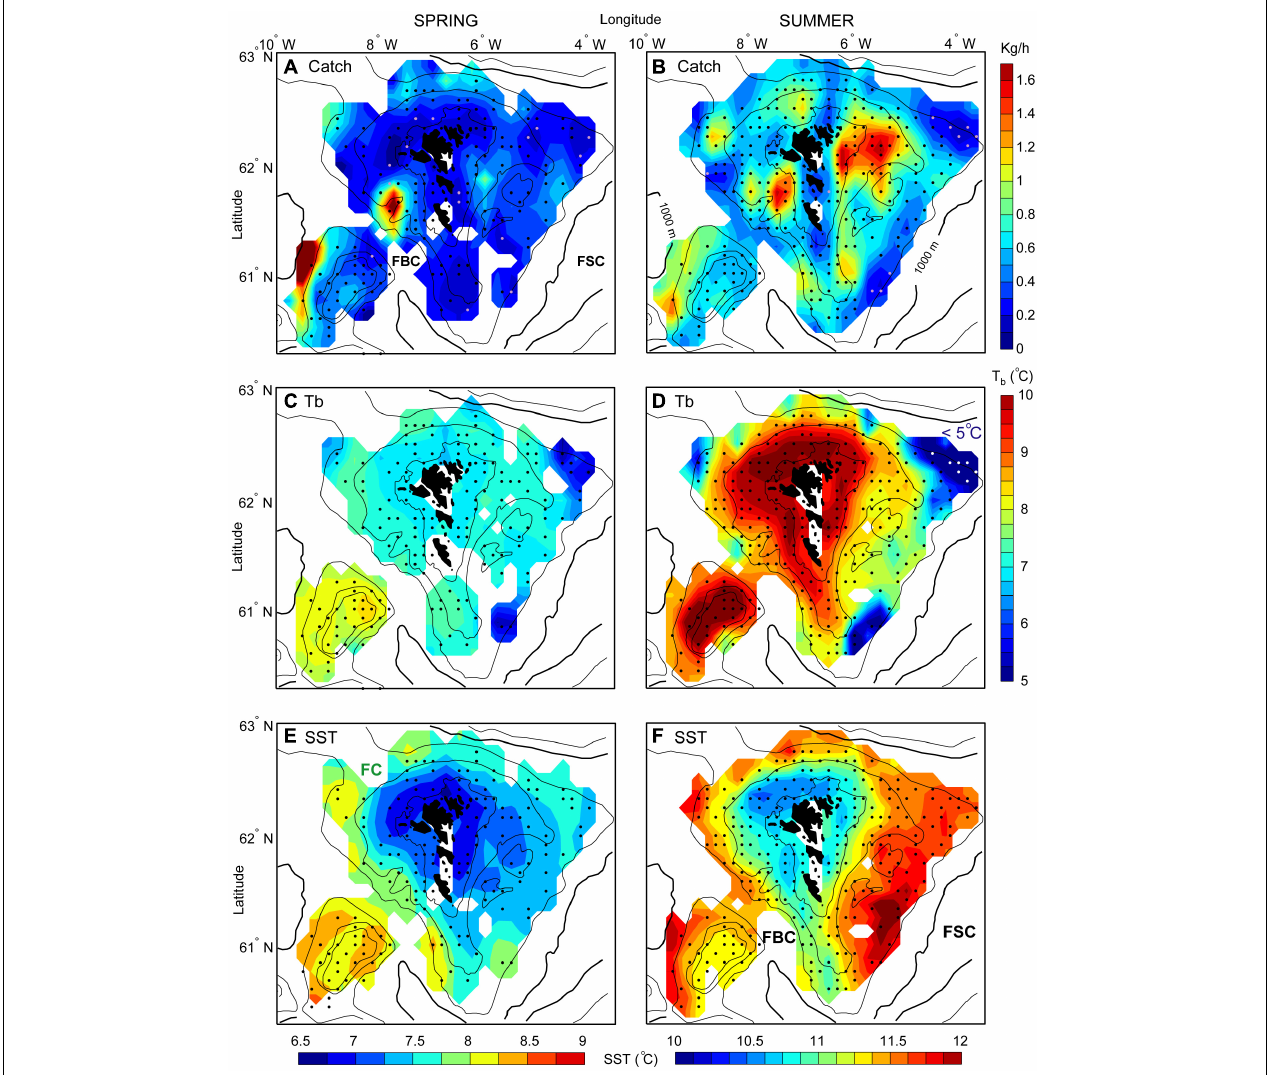
FIGURE 4 | Distribution of anglerfish (catch, kg/h), bottom temperatures (Tb) and Sea Surface Temperature (SST) in Faroese waters from two annual Faroese groundfish surveys in spring (A,C,E) and summer (B,D,F) . The data are gridded for each seasonal survey, and averaged over the years 2000–2020 (see “Materials and Methods”). The 100, 200, 500, and 1,000 m depth contours are shown. The black dots [and a few light purple dots when 0 anglerfish is caught in panels (A,B) ] represent standard trawl station positions for each season. Note that the darkest blue coloring in panel (D) can have temperatures lower than 5 ◦ C (indicated by the white dots). FBC, Faroe Bank Channel; FSC, Faroe-Shetland Channel. Note that the color scales are different for the catch, Tb and SST